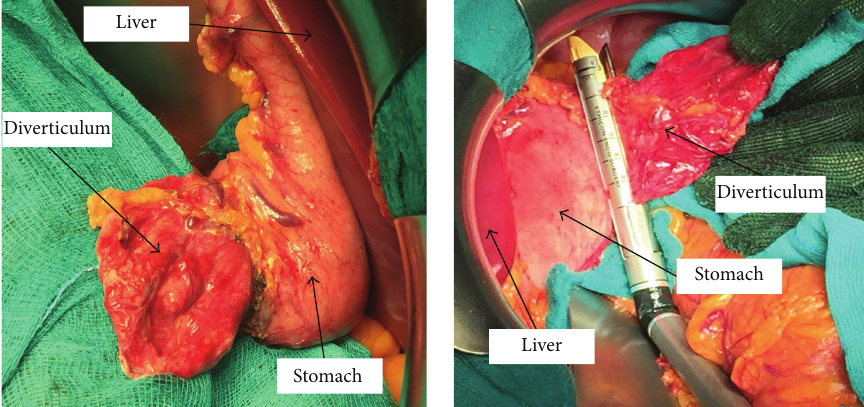
Figure 3: Intraoperative view. The gastrocolic ligament and the short gastric vessels have been released and the stomach is rotated to expose the superior-posterior wall. The adhesions between the diverticulum and the posterior surface of the pancreatic body have been dissected. Exposure of the neck of the diverticulum for preparation of diverticulectomy and resection of the neck with the linear